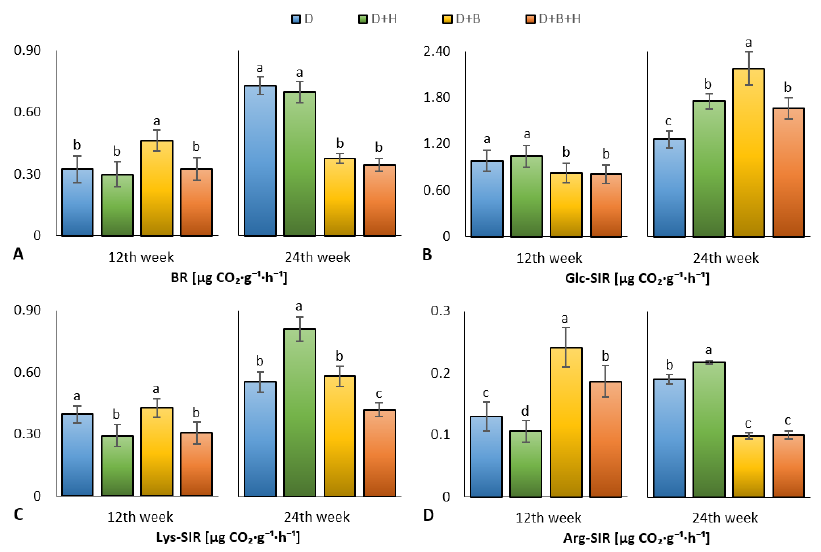
Figure 2. Basal respiration ( A ), D-glucose-induced respiration ( B ), L-lysine-induced respiration ( C ), and L-arginine-induced respiration ( D ) in the first and the second part of pot experiment. Different letters indicate statistically significant differences of Tukey HSD post-hoc test at p ≤ 0 .05.